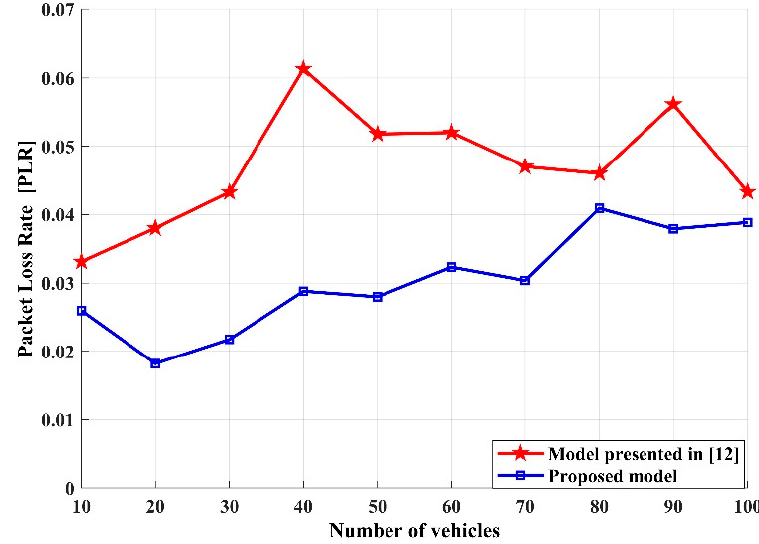
Figure 15. Packet loss rate (PLR) vs. number of vehicles at variable vehicles’ velocity.